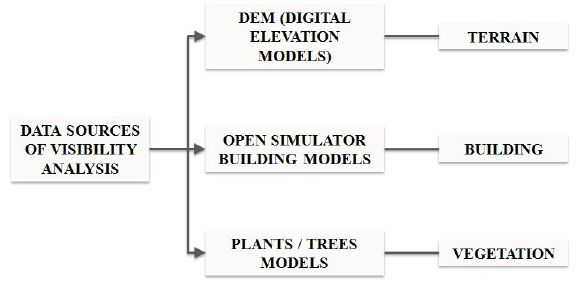
Figure 3. Integration of 3 Types of Data Sources in the 3D Visibility Analysis